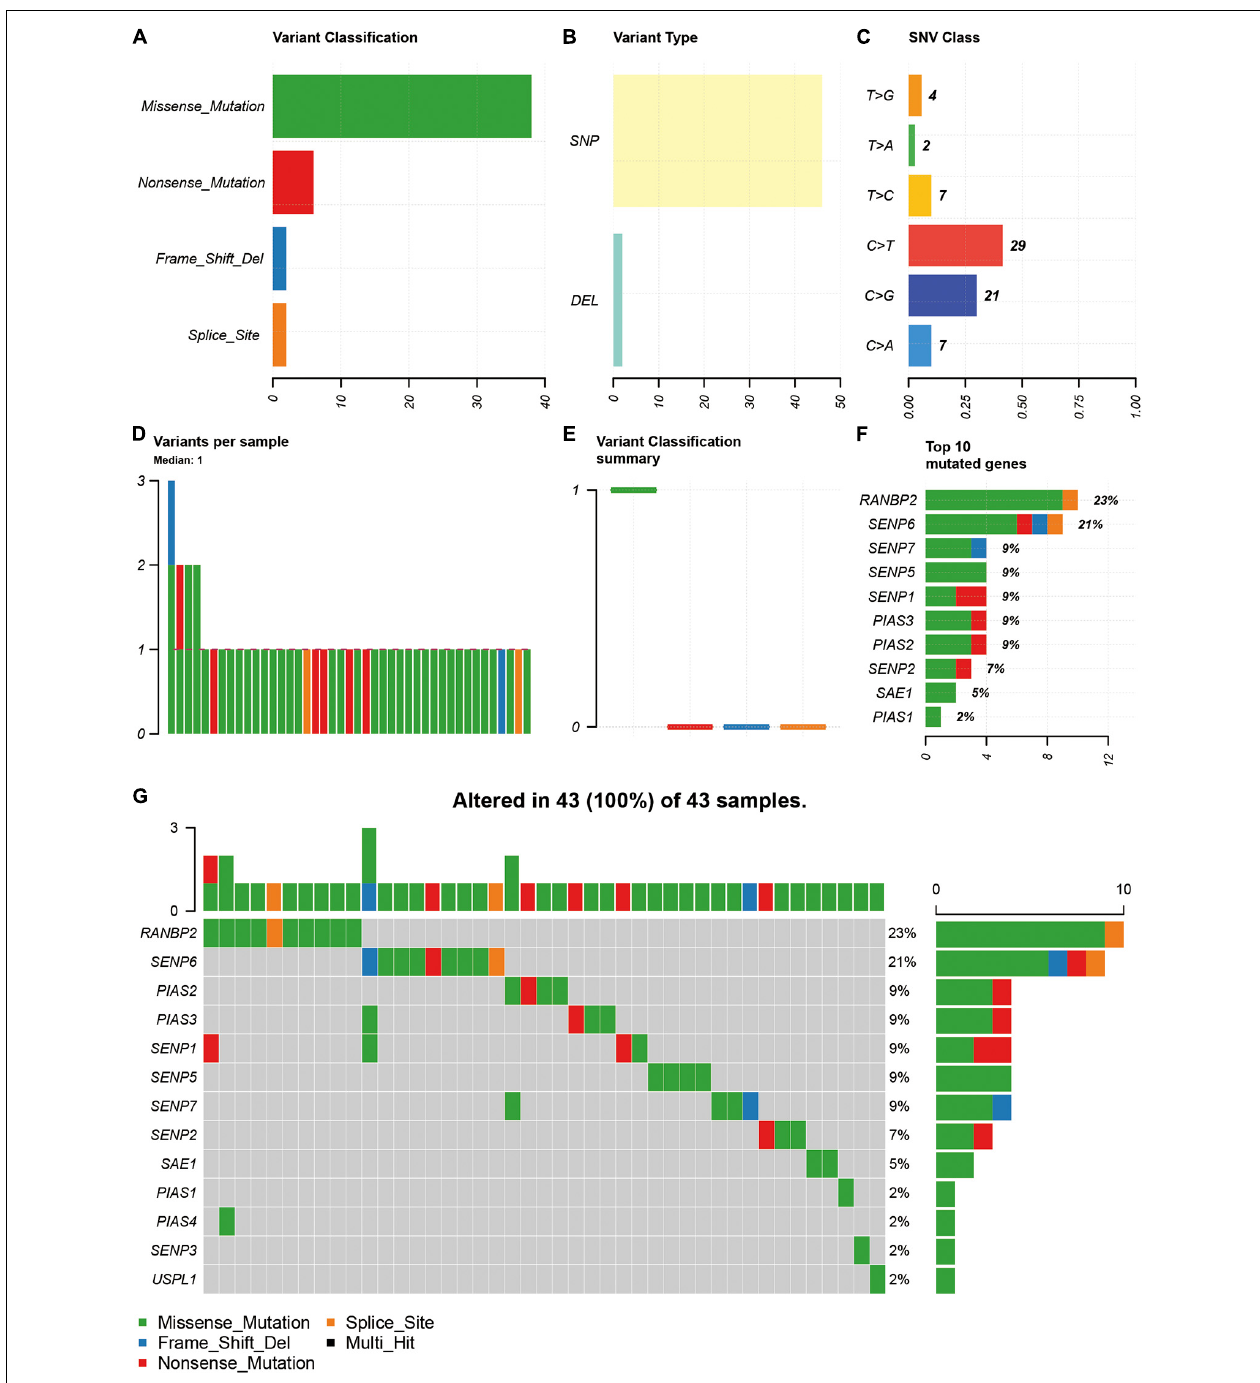
FIGURE 1 | Summary of SNV of SUMOylation regulators in OSCC. (A–C) The SNV classification and type of OSCC. (D,E) SNV in specific samples. (F) The frequencies of SNV of SUMOylation regulators. (G) Waterfall plot of SNV in the TCGA samples.